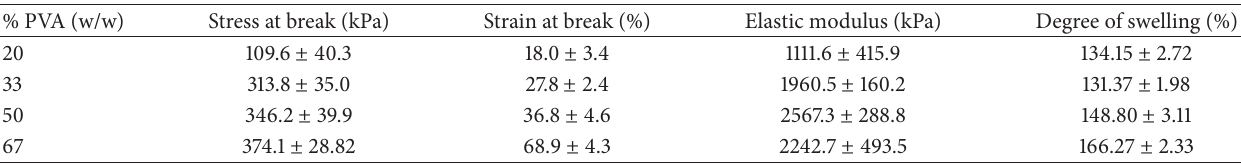
Table 2: The mechanical properties and degree of swelling of SF-CS-PVA films at varied PVA concentration. Data are represented as mean ± standard